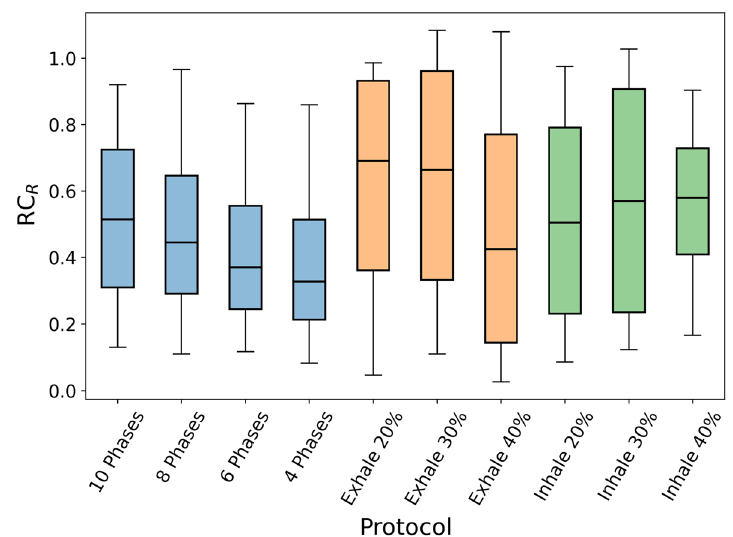
Fig. 13 Boxplots of the rod RC per